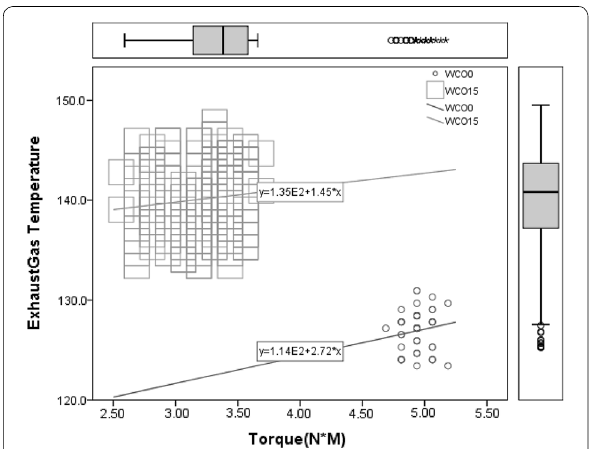
Fig. 10 Scatter plot diagrams for the exhaust characteristics versus torque output [Exhaust gas temperature (Unit: °C)]